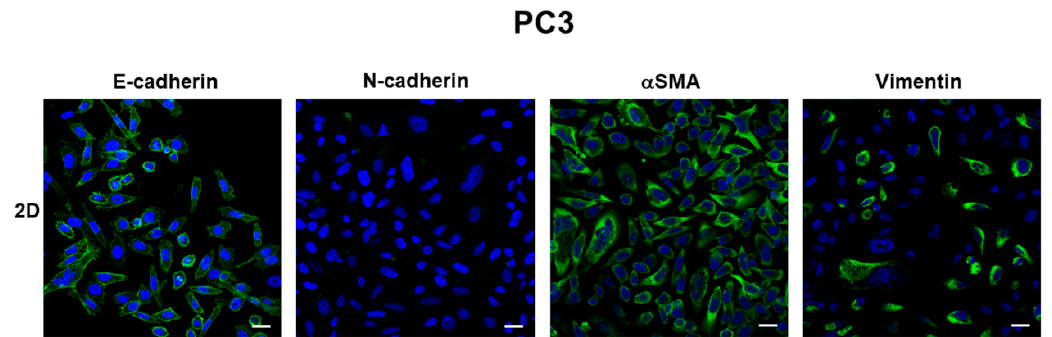
Figure 3. Immunofluorescence analysis of epithelial-to-mesenchymal transition (EMT) markers in PC3 cells. Micrographs using the confocal microscope showing the epithelial marker E-cadherin and mesenchymal markers N-cadherin, α SMA and vimentin (green) in PC3 cells grown in 2D-monolayers. Original magnification: 40×. Bar: 20 µm. Blue: DAPI.